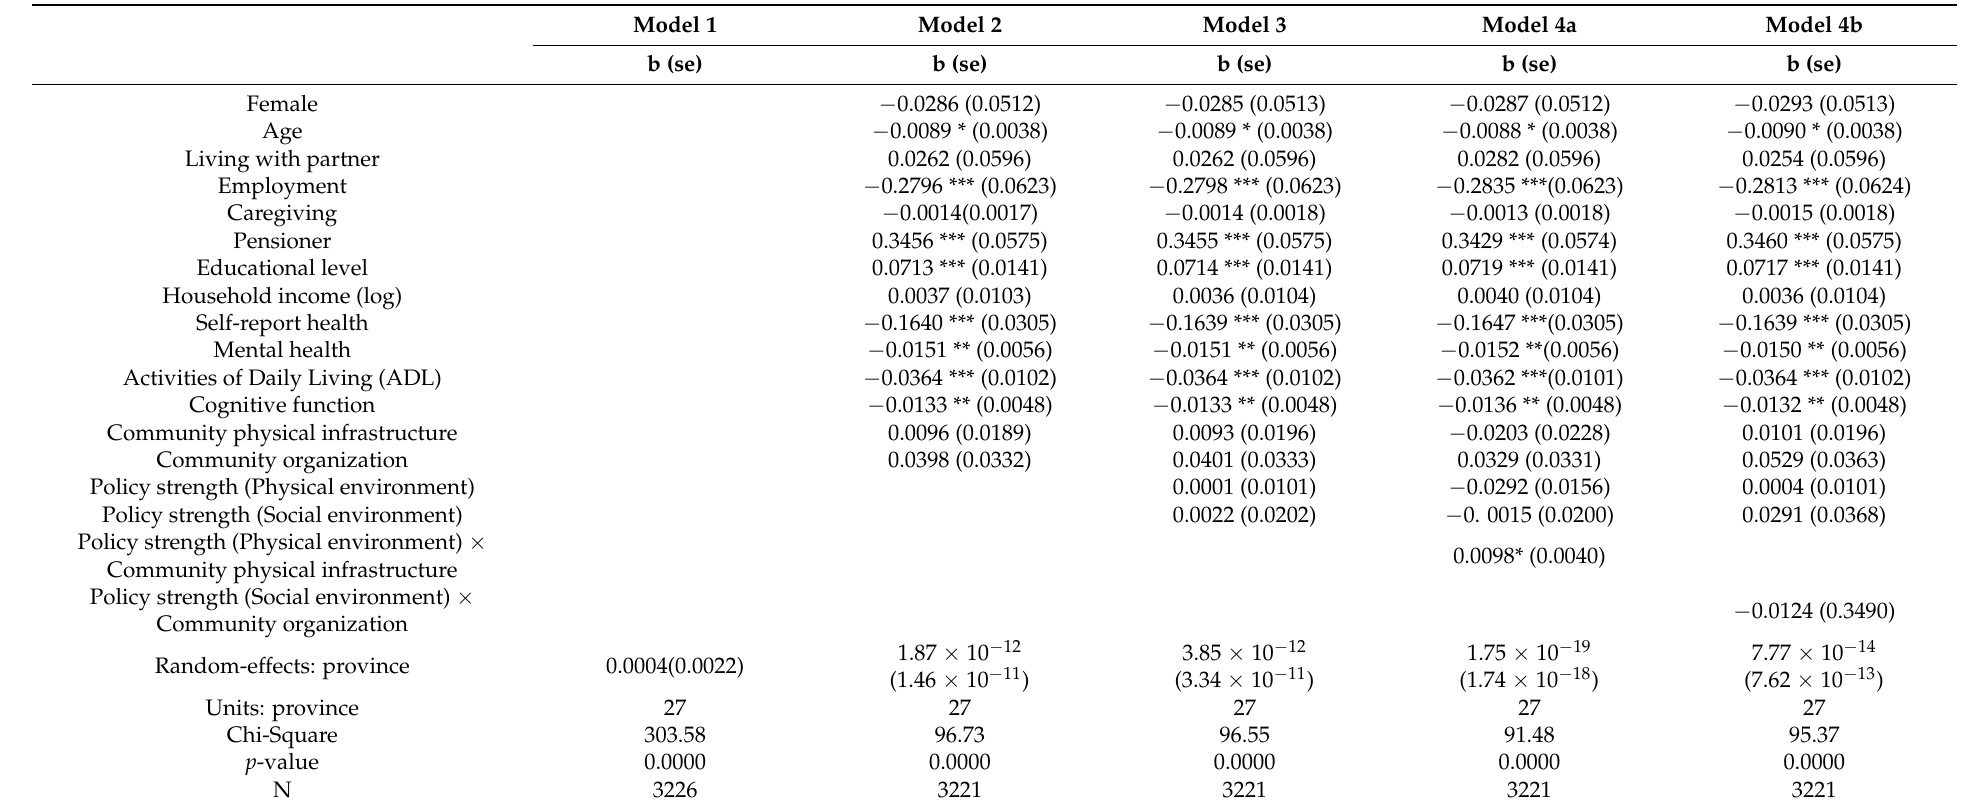
Table 1. Results of Multilevel Linear Models for the Social Participation Score of Urban Older Adults in